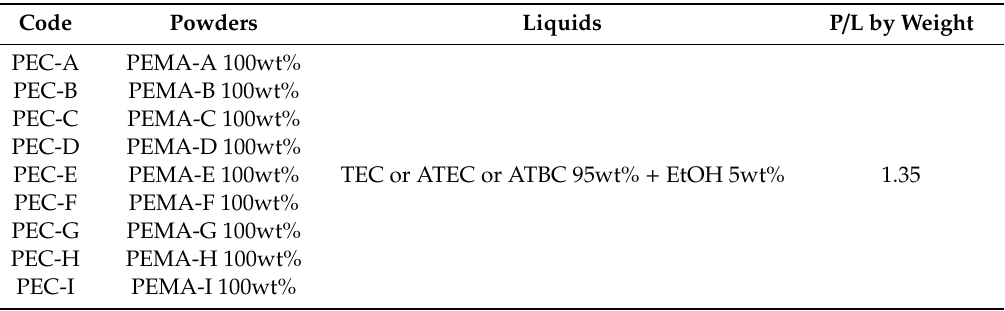
Table 3. Formulations of